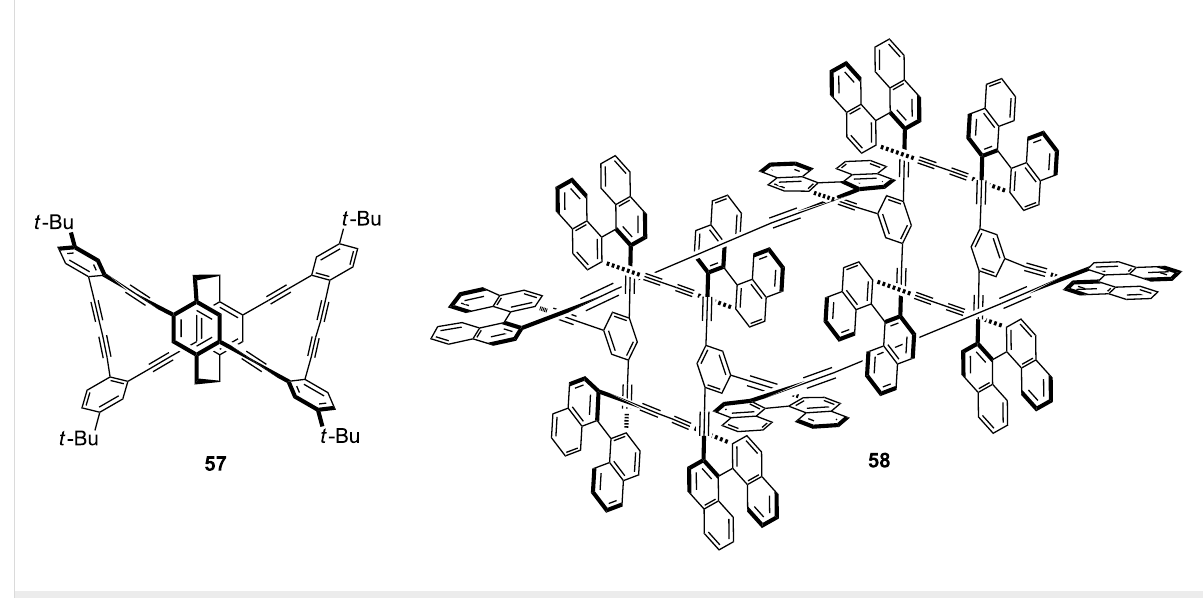
Figure 7: Synthesis of tetrasubstituted [2.2]paracyclophane 57 and chiral cyclophyne 58 through Eglinton coupling.